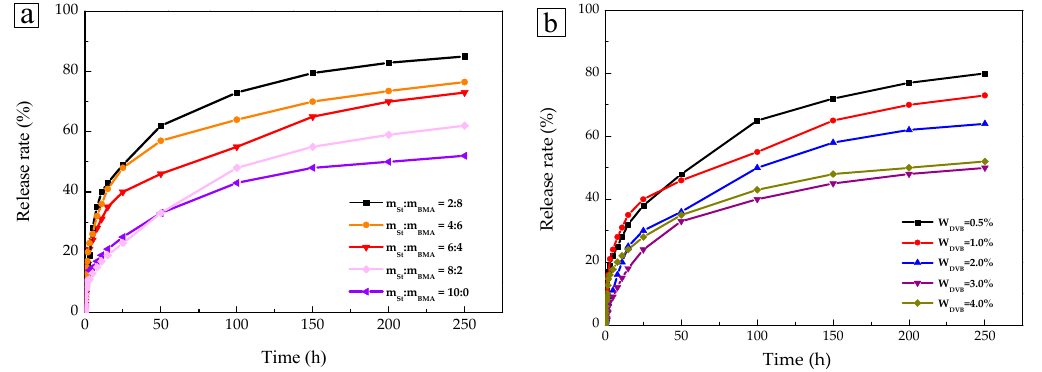
Figure 5. ( a ) Sustained release properties of the TTO microspheres at different monomer ratios and ( b ) sustained release properties of TTO microspheres at various dosages of the DVB crosslinking agent.